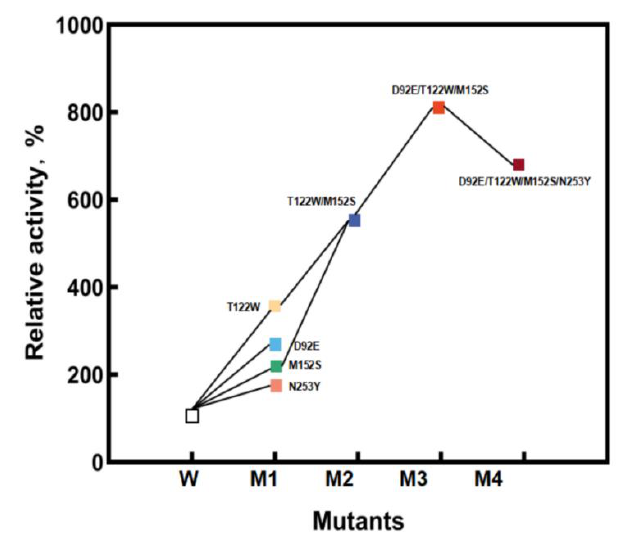
Figure 4. The process of iterative saturation mutagenesis.